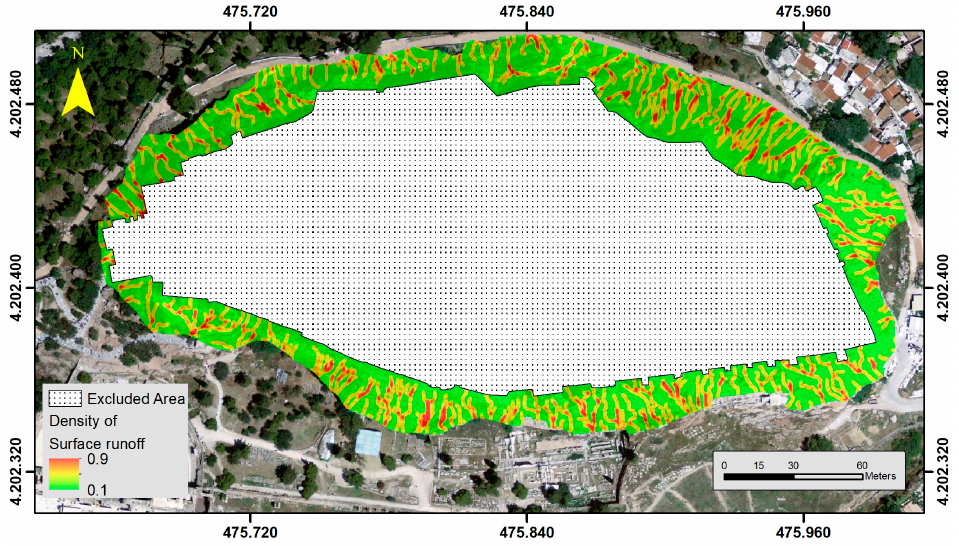
Figure 10. Instability related parameters (normalized): Density of surface runoff elements.